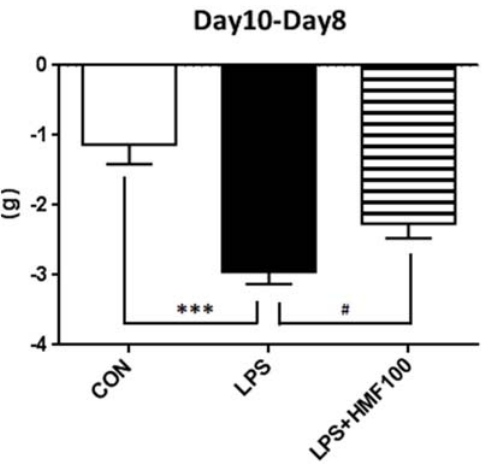
Figure 2. Effects of the subcutaneous administration of HMF on LPS-induced losses in body weight. Values are the means ± SEM. Symbols are significantly different for the following conditions: CON; control group vs . LPS, *** p < 0.001; LPS vs . LPS + HMF100, # p <